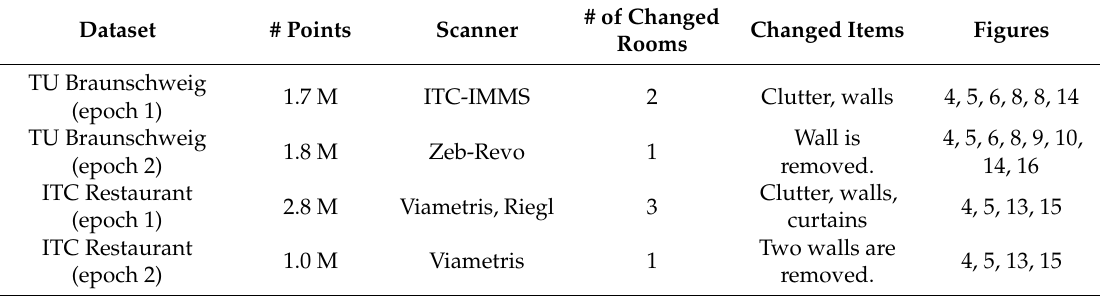
Table 2. The details of the datasets and two case studies. The first and second rows belong to the first case study. The table shows the number of points and scanning device per dataset. The fourth column shows the number of changed rooms before and after the renovation of the building. The fifth column shows the items which are identified as changes.